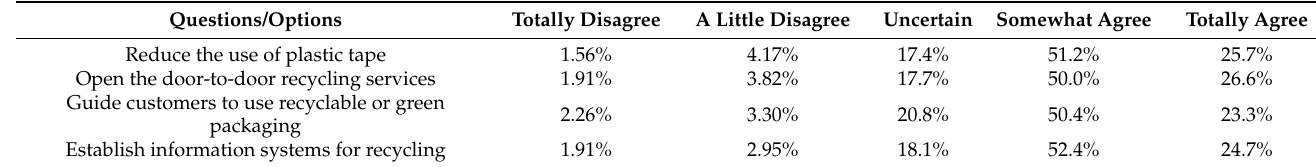
Table 6. Respondents’ awareness of logistics corporate